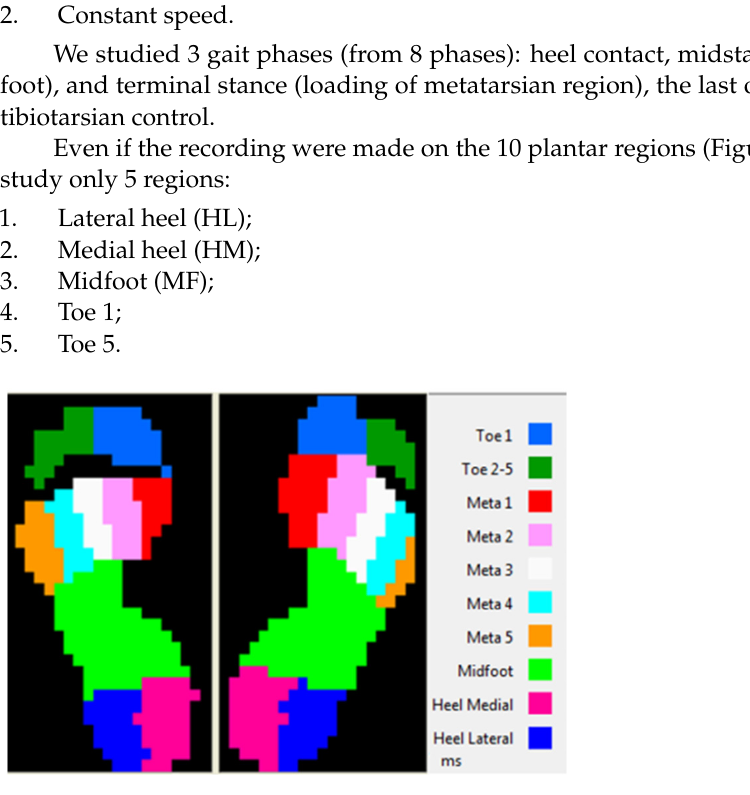
Figure 3. Plantar regions.